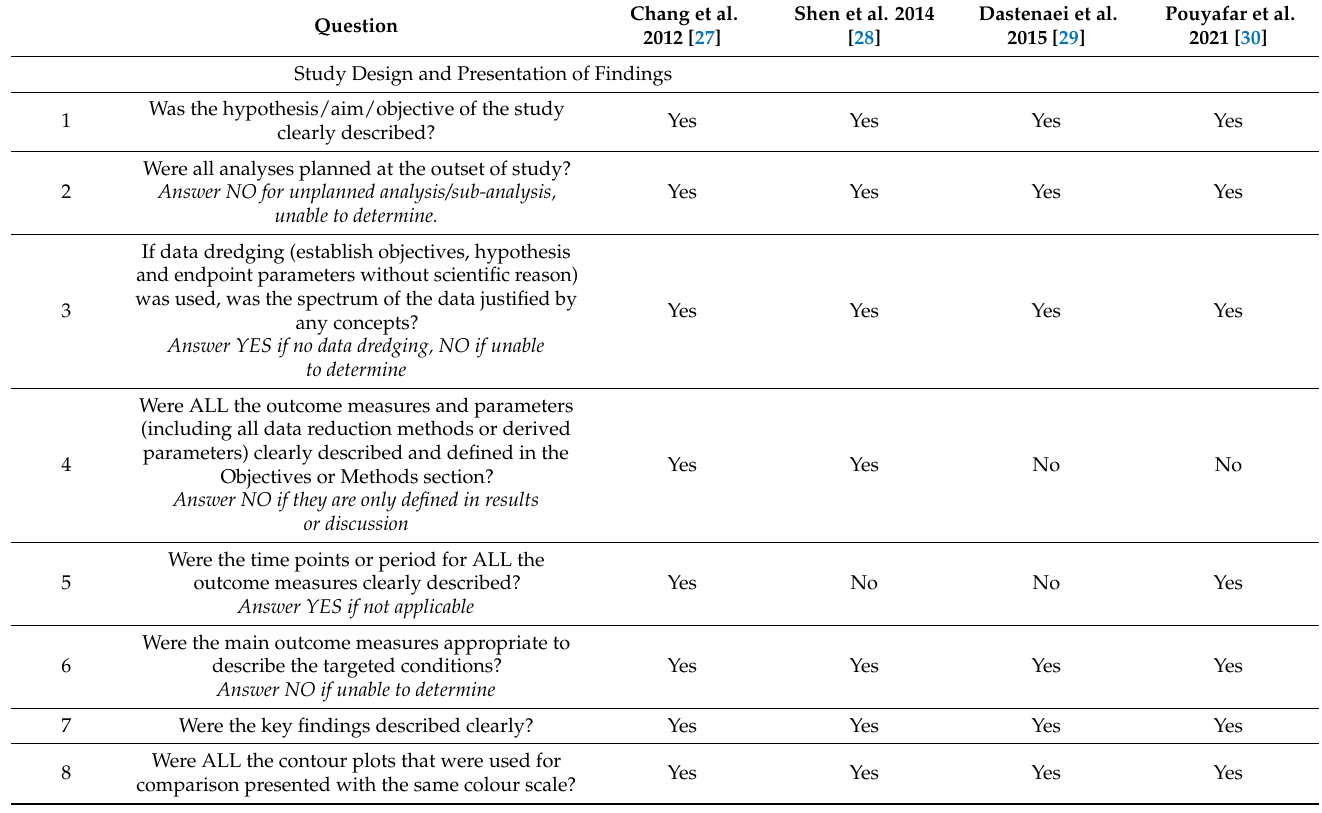
Table 3. Quality Assessment according to Methodological Quality Assessment of Single-Subject Finite Element Analysis Used in Computational Orthopaedics